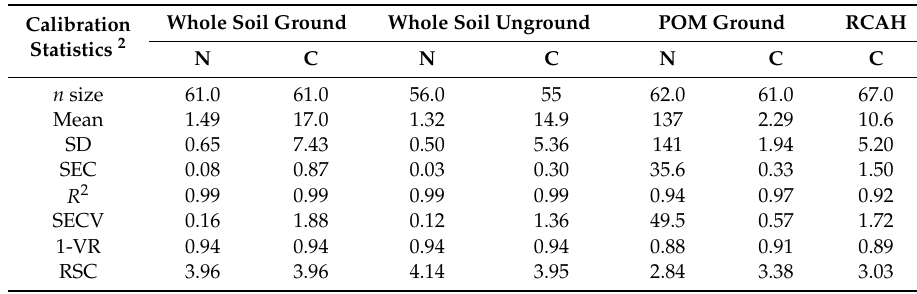
Table 4. Calibration models developed for the prediction of whole and ground soil carbon (TSOC) and nitrogen (TSN), particulate organic matter carbon (POMC) and nitrogen (POMN), and residual C of acid hydrolysis (RCAH).